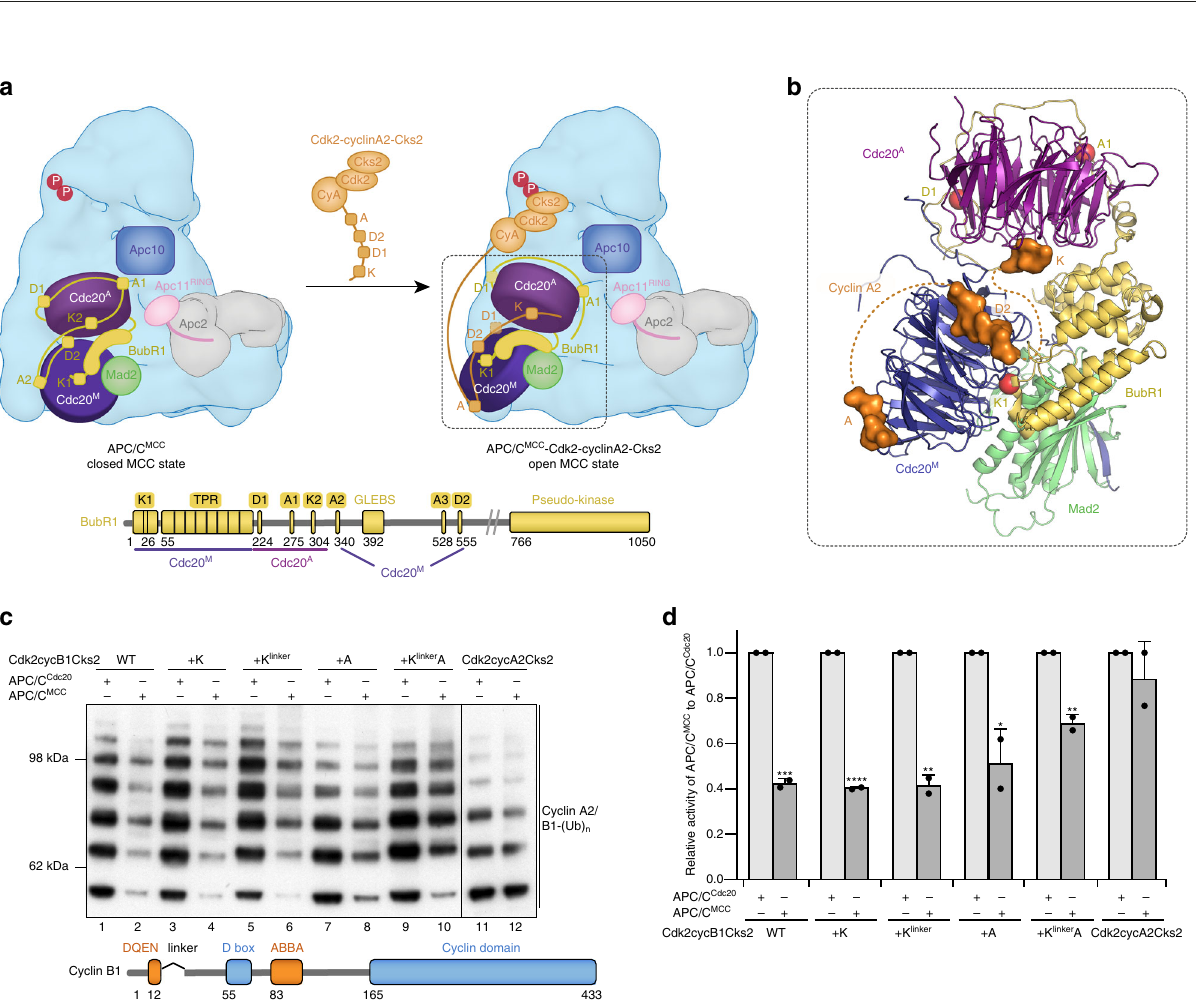
Fig. 6 Cdk2-cyclinA2-Cks2 associates with APC/C MCC , with its ABBA motif and D2 box binding to Cdc20 M . a – d Size exclusion chromatography showed formation of a stable APC/C MCC -Cdk2-cyclinA2-Cks2 complex with a peak shifted to higher molecular weight (blue line) compared to either APC/C MCC (purple line) or Cdk2-cyclinA2-Cks2 alone (red line). Cdk2-cyclinA2-Cks2 was added at a molar ratio of 33:1 to APC/C MCC , where it could ef fi ciently resist MCC-mediated inhibition in the ubiquitination assays. The fractions of APC/C MCC -Cdk2-cyclinA2-Cks2 ( b ), APC/C MCC alone ( c ) and Cdk2-cyclinA2- Cks2 alone ( d ) were analysed on SDS-PAGE. e, f Disruption of the ABBA-motif-binding pocket on Cdc20 (with point mutations I235S&Y279E) of the MCC (Cdc20 M ) strongly reduced the resistance of cyclin A2 to MCC-imposed inhibition of APC/C activity (lanes 7 – 9), whereas the same mutation on Cdc20 A had no effect (lanes 4 – 6). g , h Disruption of the hydrophobic interactions within the D-box binding site (L176A) on Cdc20 M resulted in increased inhibition of cyclin A2 ubiquitination by APC/C MCC (lanes 7 – 9). The histogram of relative APC/C MCC activity is normalized to respective APC/C Cdc20 activity, with Table 2). Source data are provided as a Source Data fi